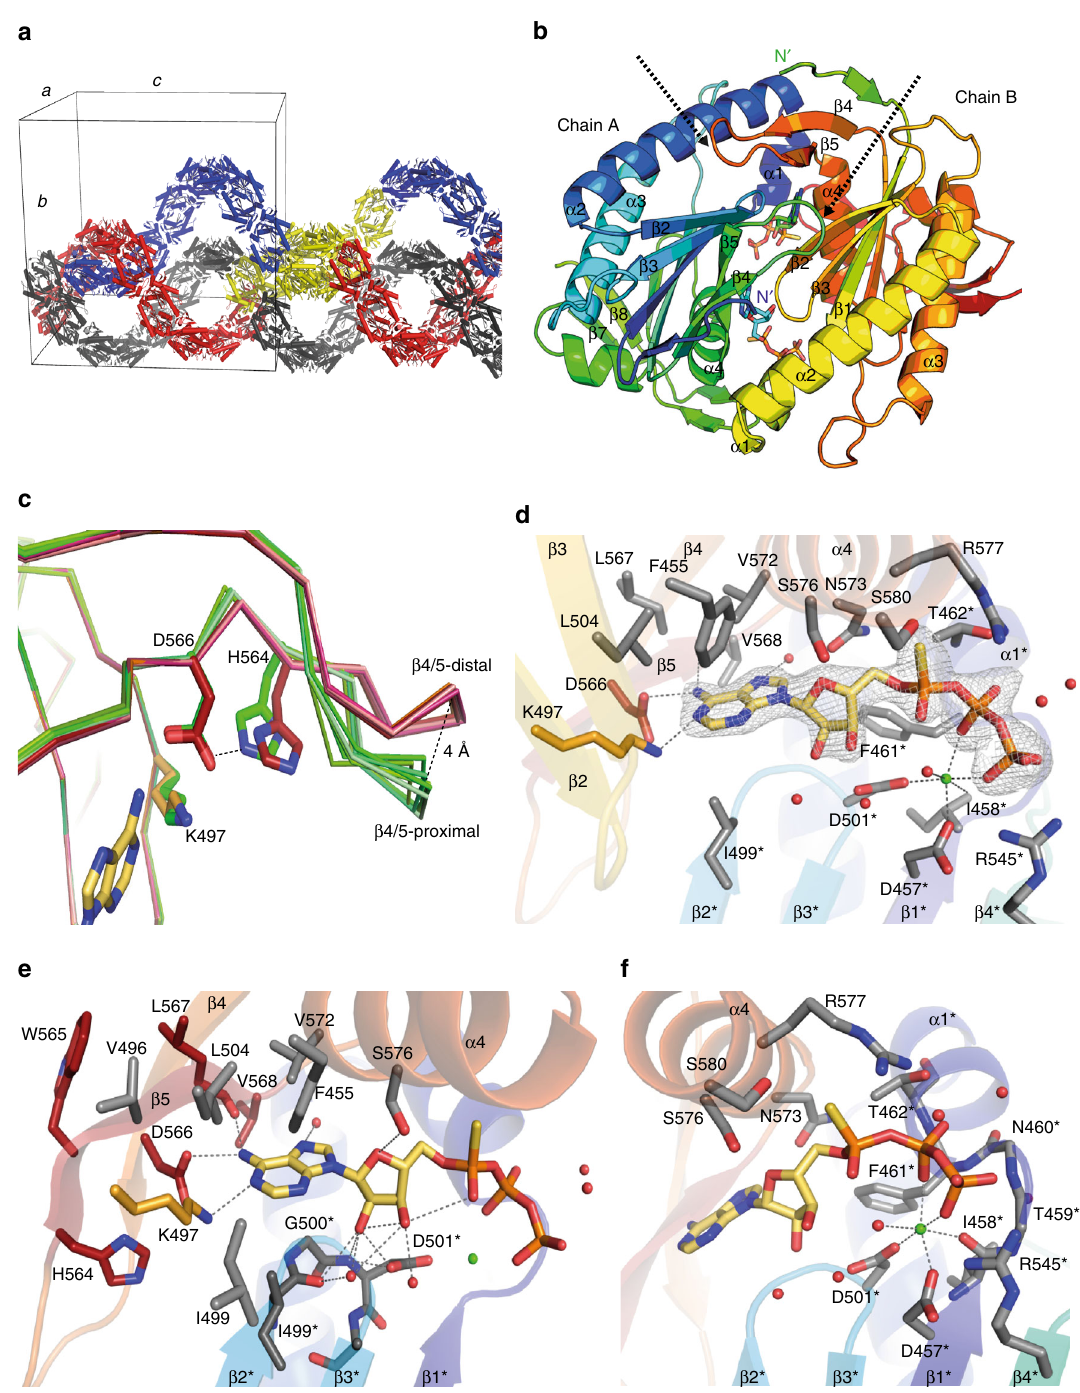
Fig. 7 Crystal structure of CaAC in complex with ATP α S. a CaAC (E497K/C566D) homodimers form an intertwined helical superstructure within the crystal lattice (blue, red, gray indicate individual superhelices, yellow indicates 8 homodimers within a single asymmetric unit). b Each homodimer consists of two antiparallel arranged monomers and harbors 2 active sites at the dimer interface, occupied by the ATP analog: ATP-Sp- α S. Arrows indicate β 4/5 loops, N-termini are labeled, chain A: blue/green, chain B: green/red. c Comparison of the β 4/5 loop orientation in CaAC. Overlay of the six monomers of CaAC found in the loop-proximal (green) position close to the catalytic core, or the loop-distal (orange) position. The protein backbone is visualized as a ribbon with selected residues and the base head group shown as sticks. d CaAC active site; the adenine base and phosphate tail of ATP-Sp- α S are anchored by different monomers. Residues of the phosphate binding monomer are marked (*). The previously mutated residues E497K (orange), C566D (red) form hydrogen bonds to the adenine base. The ribose is tilted perpendicular to the adenine plane and points towards β 2*, β 3*. The conserved arginine, R577 ( α 4) orients towards P α . The ion B site is occupied by Ca 2 + , which is octahedrally coordinated among others by two conserved aspartates, D457* and D501*. The phosphate tail of ATP-Sp- α S is anchored to the α 1/ β 1-loop via polar interactions. mFo-DFc omit map for ATP-Sp- α S contoured at 5 σ , contour level is shown as gray mesh. e Magni fi cation of the adenine base binding residues. Neighboring residues of D566, situated on β 5 and mutated in RhACs- 6 × are colored in red. f Magni fi cation of the residues, involved in nucleotide phosphate binding, coloring as in d . Gray dashed lines indicate hydrogen bonds or metal coordination between 2.3 Å and 3.6 Å in